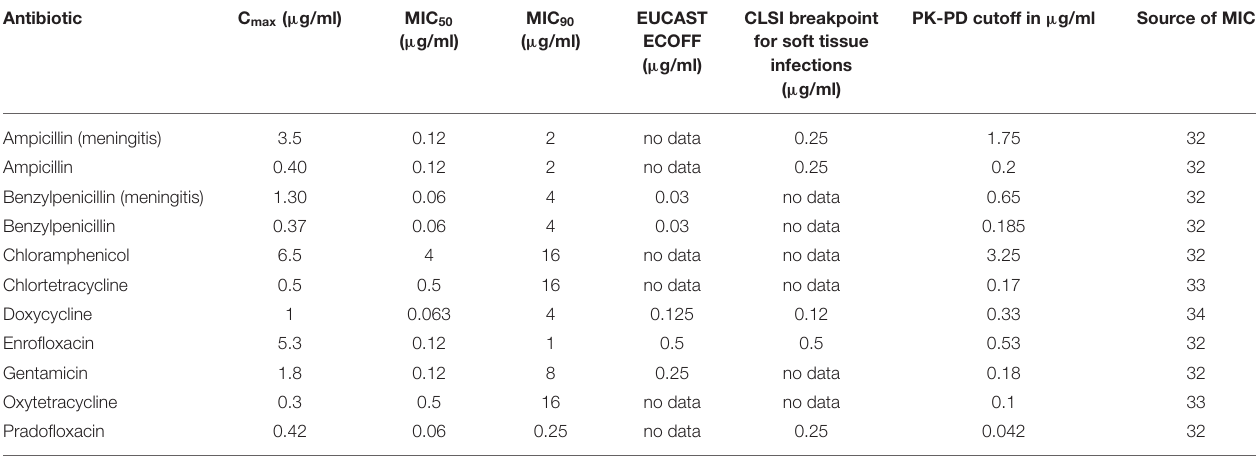
TABLE 8 | C max in CSF in dogs after the administration of various antibiotics in healthy dogs or during meningitis (ampicillin, benzylpenicillin) and selected PK-PD cutoffs of Staphylococcus pseudintermedius . Antibiotic